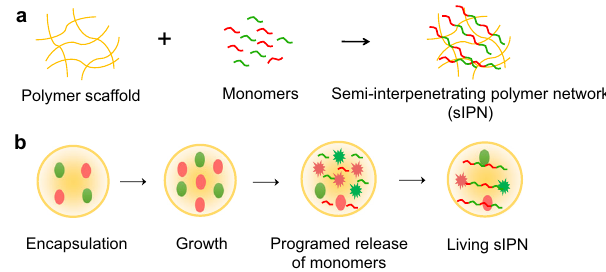
Fig. 1 Conventional and living fabrication of semi-IPN. a A semi- interpenetrating polymer network (sIPN) is de fi ned as a linear or branched polymer in the presence of another cross-linked polymer. sIPN can be assembled by dissolving monomers (for the 2nd component) in a cross- linked scaffold (the 1st component), before initiating polymerization. b Living fabrication of sIPN using engineered bacteria. When encapsulated inside a polymeric microcapsule (the 1st component, cross-linked), the engineered bacteria can undergo autonomous lysis at a high local density. Lysis releases protein monomers that can react to form the polymerized protein (the 2nd component, polymerized but not necessarily fully cross- linked) inside the polymeric